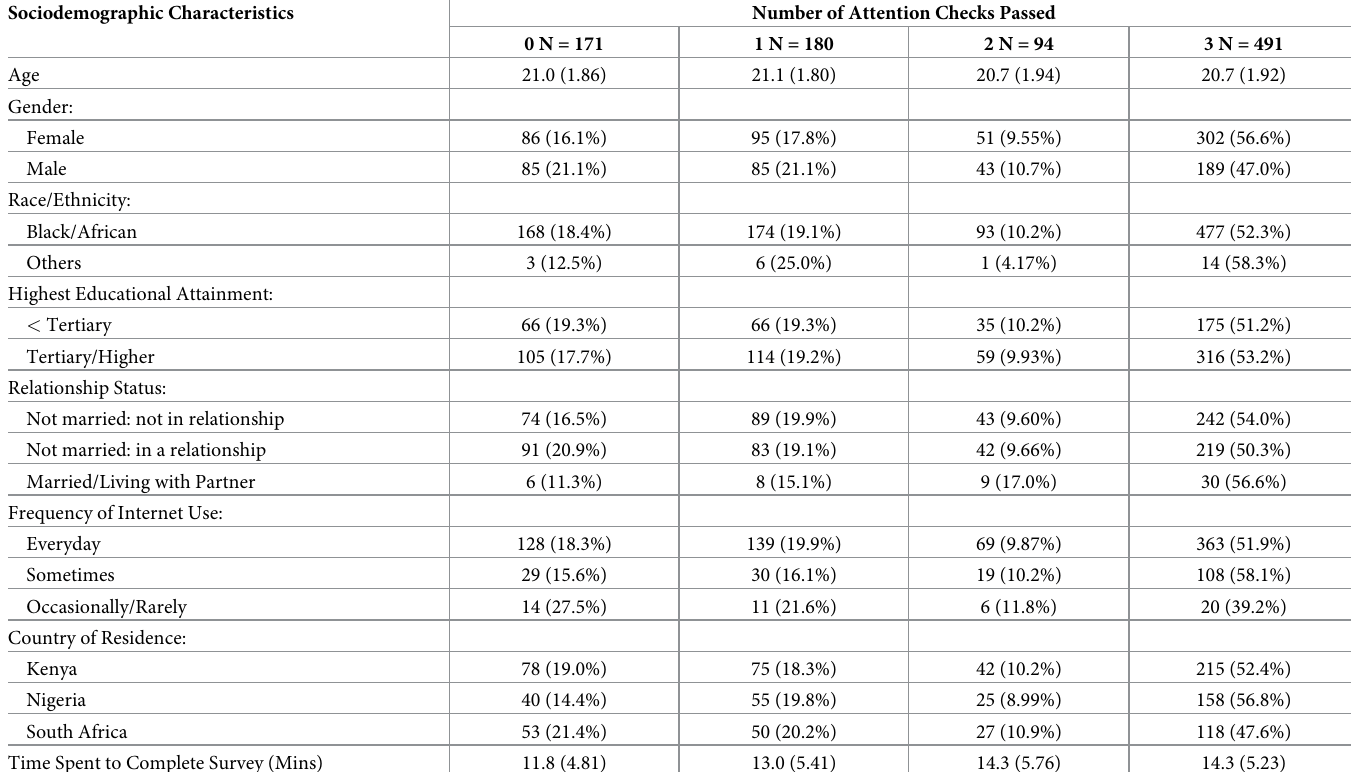
Table 5. Passage rates of attention check questions across sociodemographic characteristics. Sociodemographic